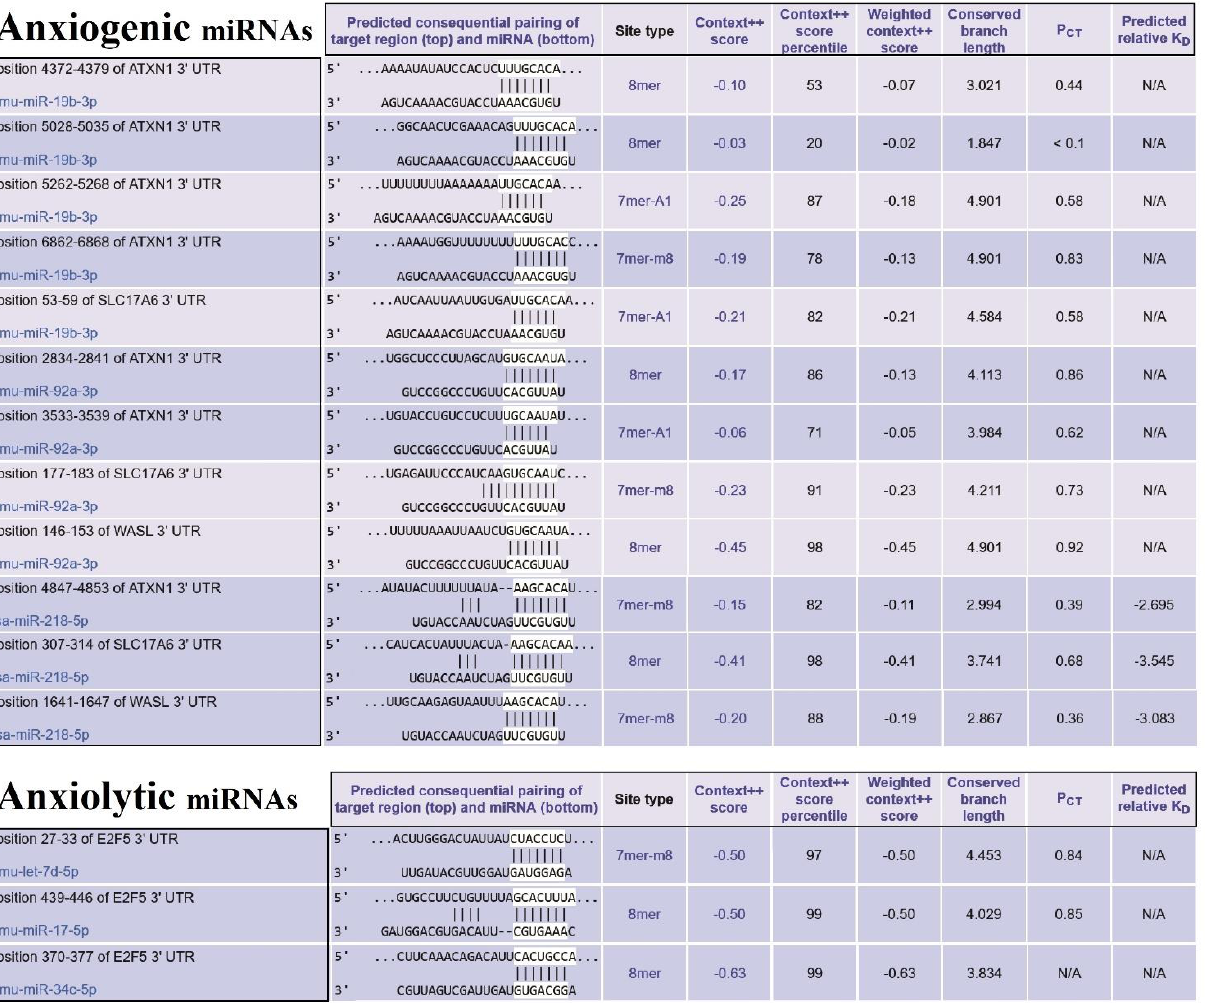
Figure 7. The miRs/mRNAs interactions and related information. ( Upper table ) The sequence of miRNAs of three selected essential proteins (SLC17A6, WASL, and ATXN1) at 3 ′ -UTR and their interaction with anxiogenic miRNAs (miR-19b, miR-92a, and 218). ( Lower table ) The sequence of miRNAs of selected important protein (E2f5) at 3 ′ -UTR and their interaction with anxiolytic miRNAs (miR-34c, Let-7d, and miR-17).